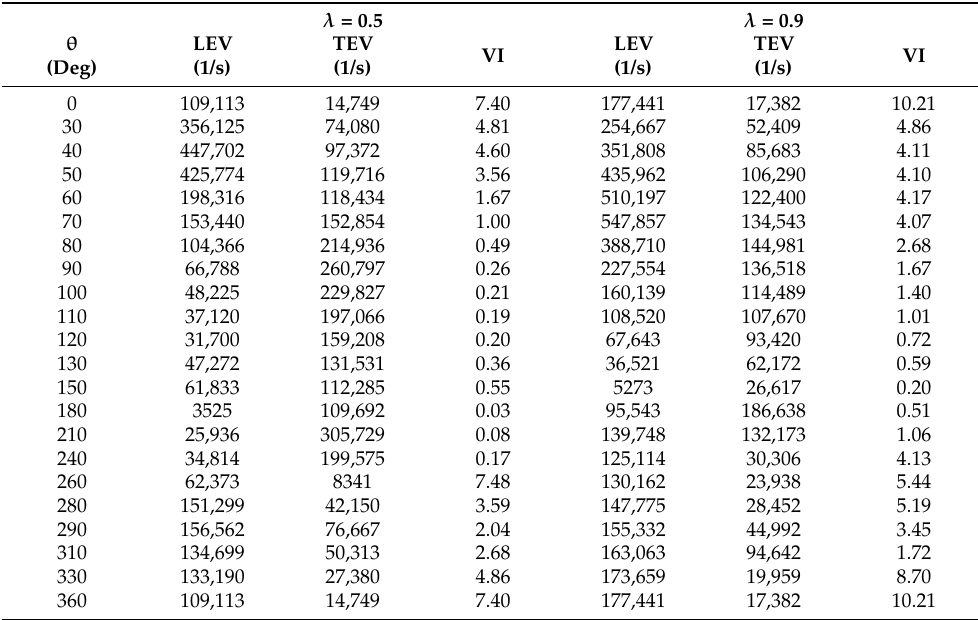
Table A1. Vorticity at the Leading Edge (LE) and Trailing Edge (TE) and VI for Blade 1 at Various Azimuthal Angles for U ∞ = 8 m/s.